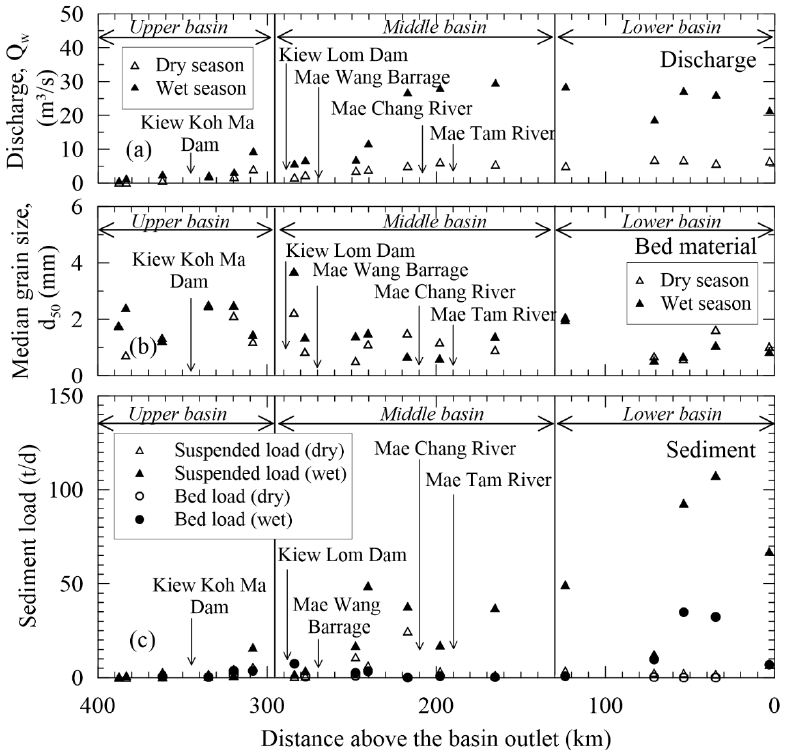
Figure 3. Observations along the Wang River during 2019: ( a ) river discharge; ( b ) median size bed material (d 50 ); ( c ) suspended sediment load and bedload. In the dry season of 2019, streamflow in the upper Wang River Basin was 0.1 – 0.7 m 3 /s and 1.8 – 4.1 m 3 /s upstream and downstream of the Kiew Koh Ma Dam, respectively. In the